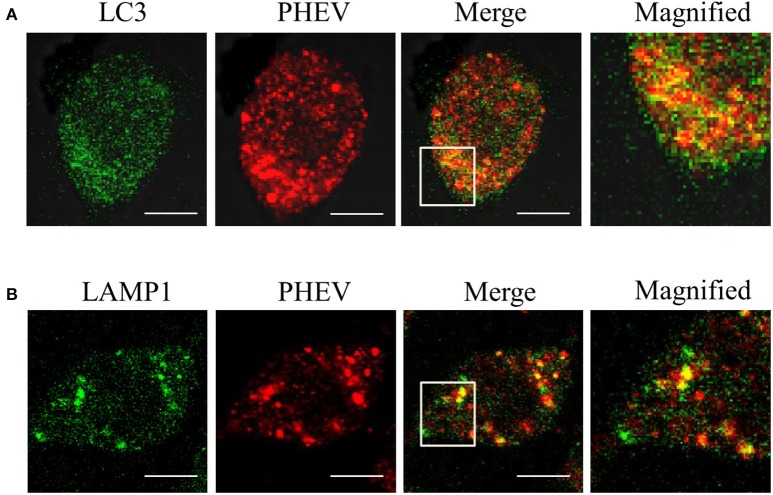
The membranes of autophagosome-like vesicles have colocalization with virions. (A,B) PHEV-infected Neuro2a cells were stained with LC3 (green) and PHEV (red) antibodies. The color-merged images are shown in the third panel. The colocalization between PHEV and LC3 and LAMP1 was magnified in the merged images. Scale bars: 10 μm.